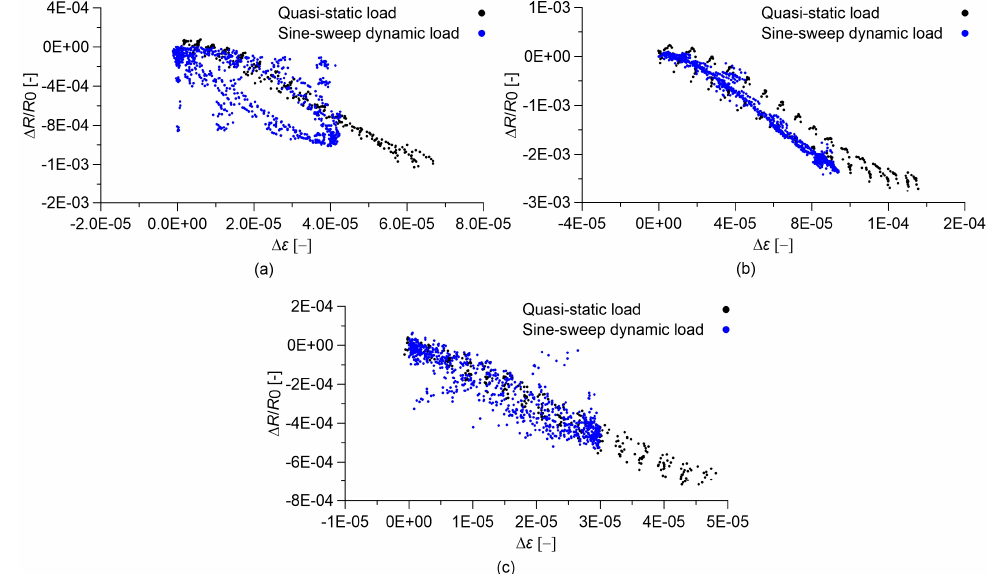
Figure 10. Relative change in electrical resistance versus applied strain of nanocomposite cured paste specimens. In the plots, R 0 is the electrical resistance value with a preload of 0.5 kN. Comparison between results obtained under sine-sweep dynamic compression loads and those obtained under quasi-static compression loads: cured paste with ( a ) 0.00% MWCNTs; ( b ) 0.50% MWCNTs; ( c ) 1.50% MWCNTs.